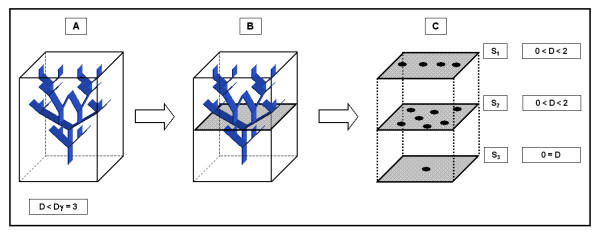
The space-filling property of the vascular system is quantified by the fractal dimension (D), which falls between two topological integer dimensions. A. A Euclidean three-dimensional space (i.e. a cube) can contain a branching structure (i.e. the vascular system) without this entirely filling its internal space. B. Two-dimensional sectioning of the vascular network makes it possible to identify a variable number of vessels depending on the geometrical complexity of the system at any particular level of sectioning. C. The geometrical complexity of a 2-D section (s1, s2, s3) of the vascular network depends in the number of sectioned vessels and their distribution pattern.